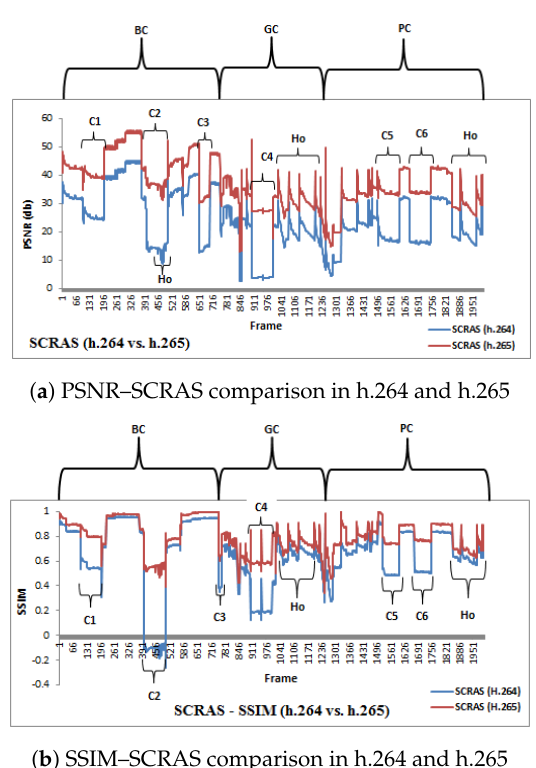
Figure 10. Impact of video encoding schemes in